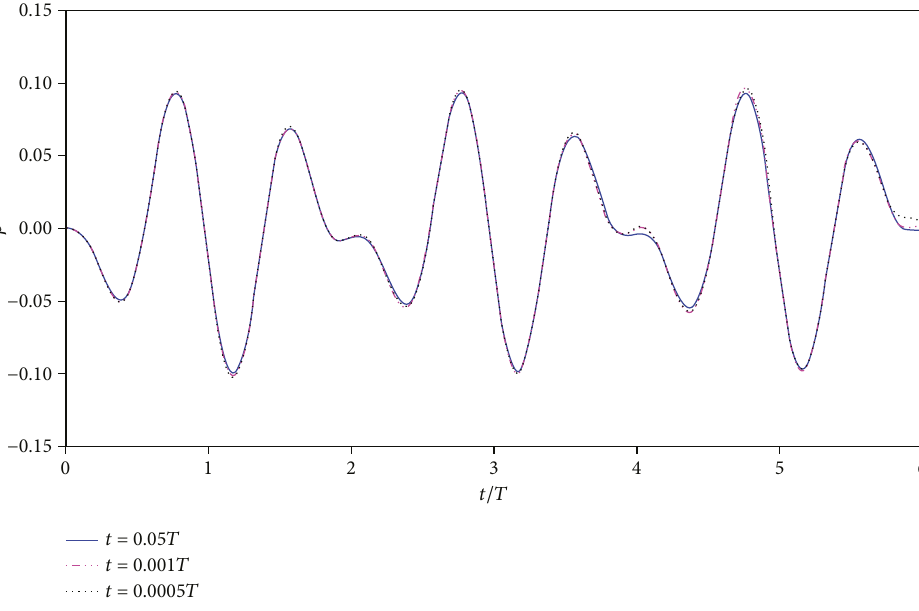
Figure 5: The time variation of passive pitching angle β under three di ff erent iteration time